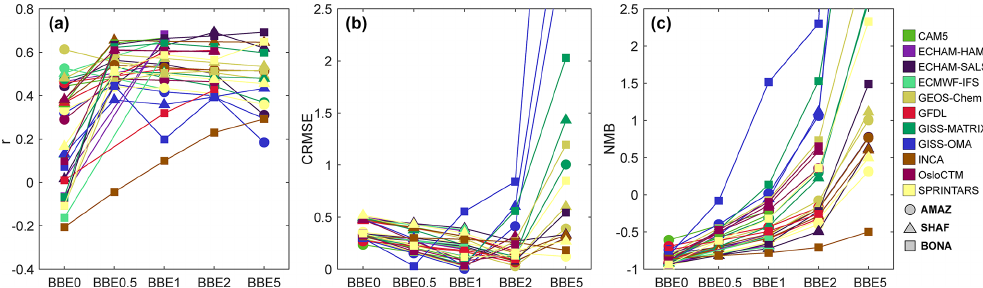
Figure 8. Changes in correlation (a) , centered root mean square error (b) , and normalized mean bias (c) in BBE in responding to different scaling factors adopted to BBA emissions (0, 0.5, 2, 5). The colors and shapes of dots indicate different models and fire regions. All data are collocated with POLDER-GRASP for fire seasons in 2008. The BBE5 CRMSE and NMB for several models are not shown given the extremely large values.